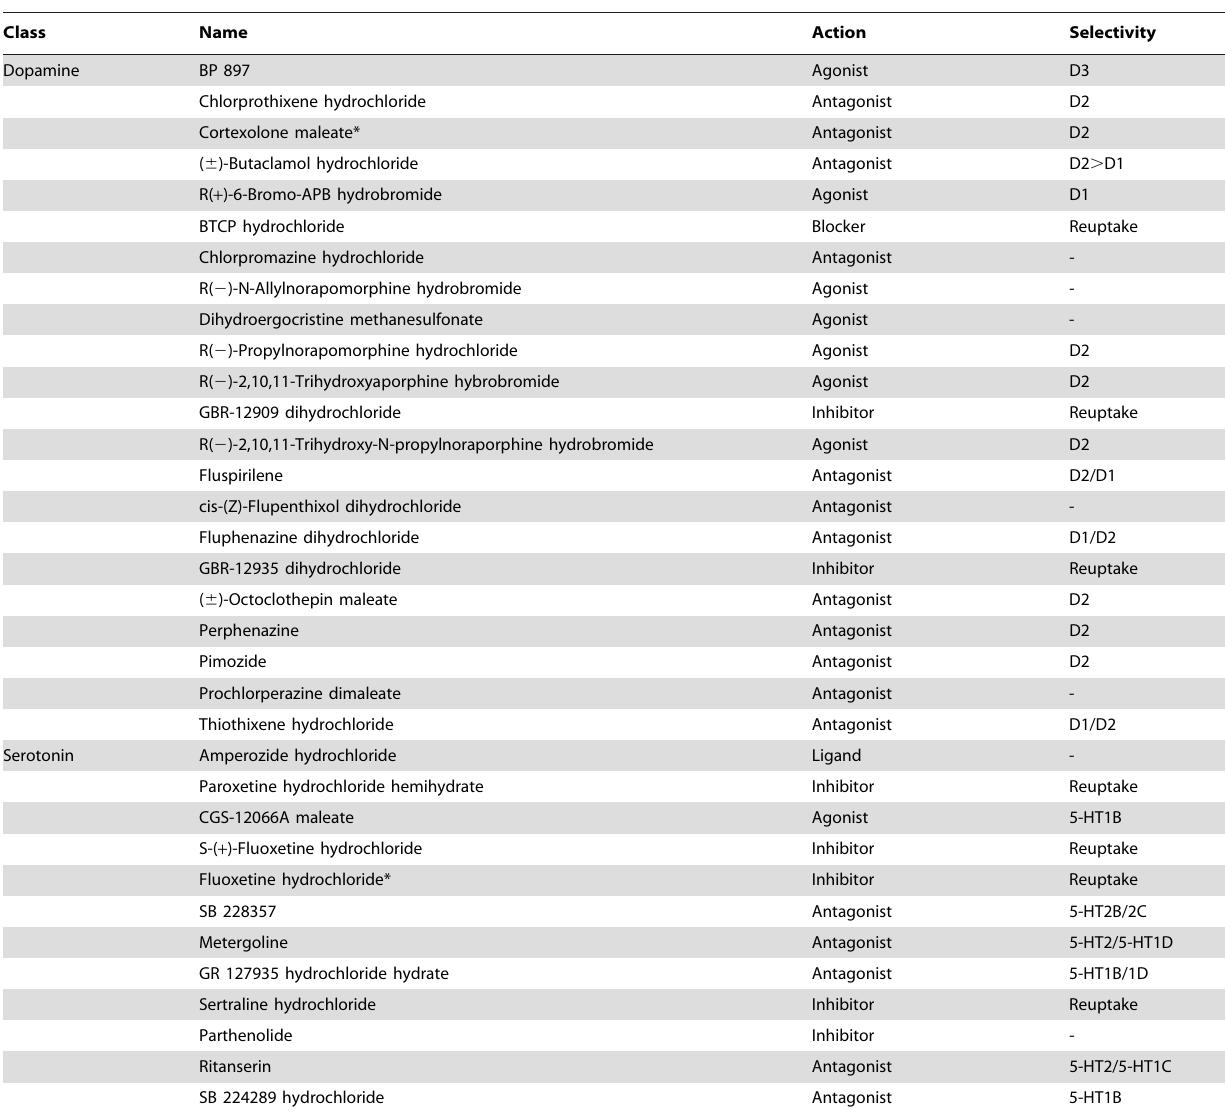
Table 2. Pharmacological agents that target neurotransmitter signaling in